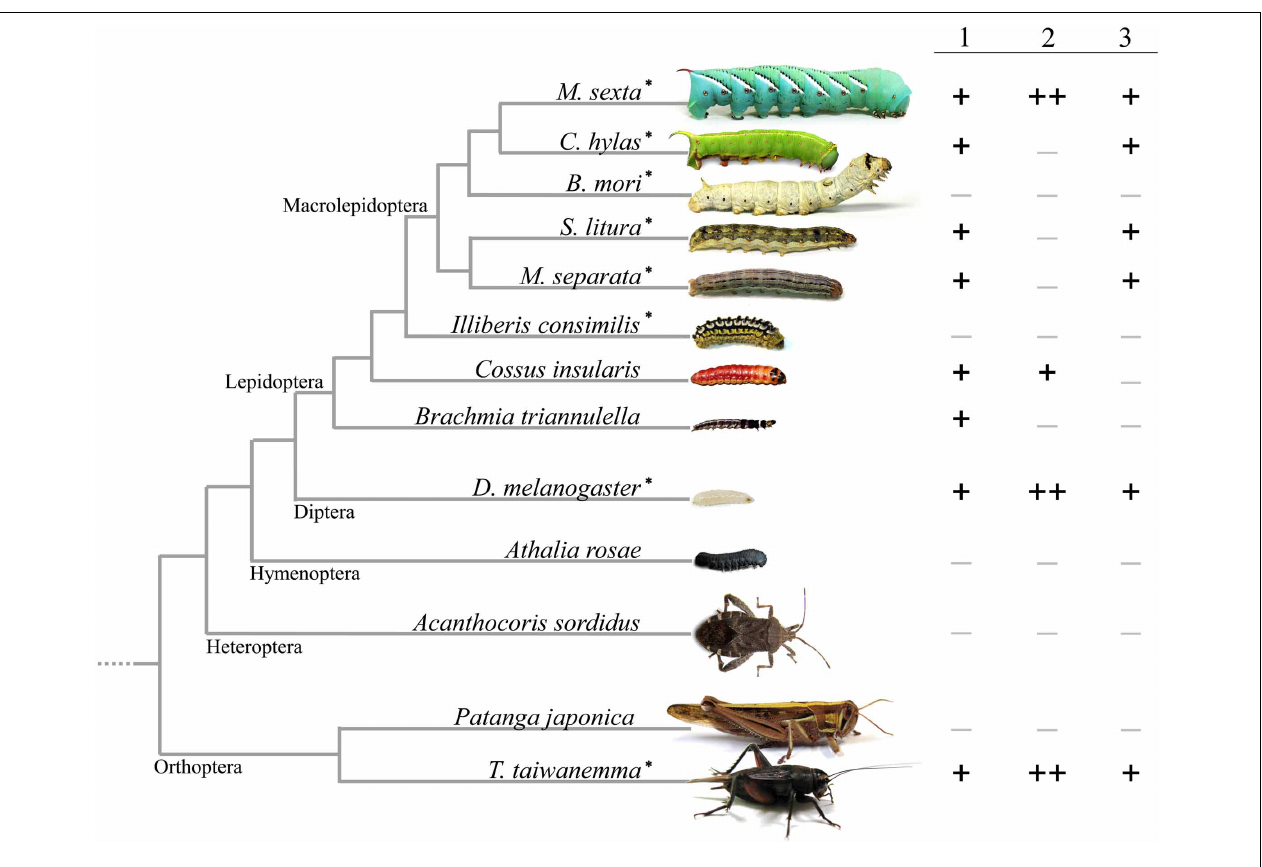
FIGURE 1 | Overview of FAC analog patterns in insects. 1, glutamine conjugates; 2, glutamic acid conjugates; 3, hydroxylated FACs. All FAC-containing species had glutamine conjugates (1) in common, and the evolutionarily earliest species in Lepidoptera